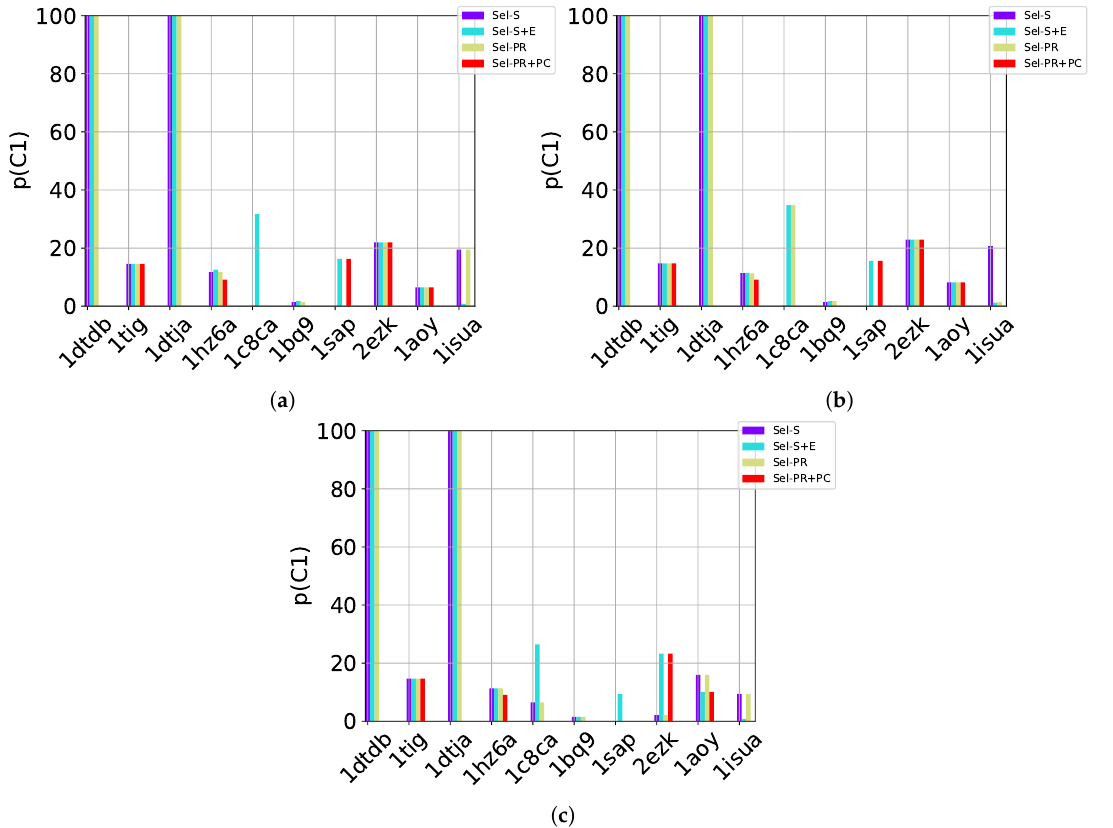
Figure 2. Comparison of the various selection strategies on the purity of the top community C 1 selected over communities detected with the Louvain method on directed nngraph embeddings of decoy data in ( a ), the Louvain method on undirected nngraph embeddings of decoy data in ( b ), and the GMM method on undirected nngraph embeddings of decoy data in ( c ).